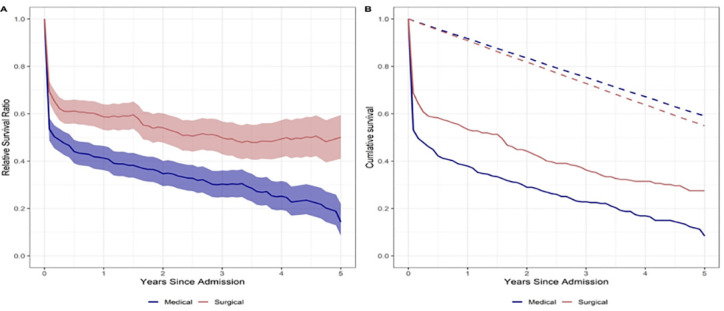
Modelled five-year survival of medical and surgical patients from ICU admission.Panel A illustrates the modelled relative survival over time. Panel B demonstrates modelled cumulative survival using the Kaplan Meier method comparing medical and surgical patients. In panel A the shaded area represents the 95% confidence intervals for the modelled relative survival ratio. In panel B the dashed lines represents the modelled cumulative survival of the UK reference population in relation to medical patients (blue dash) and surgical patients (red dash).